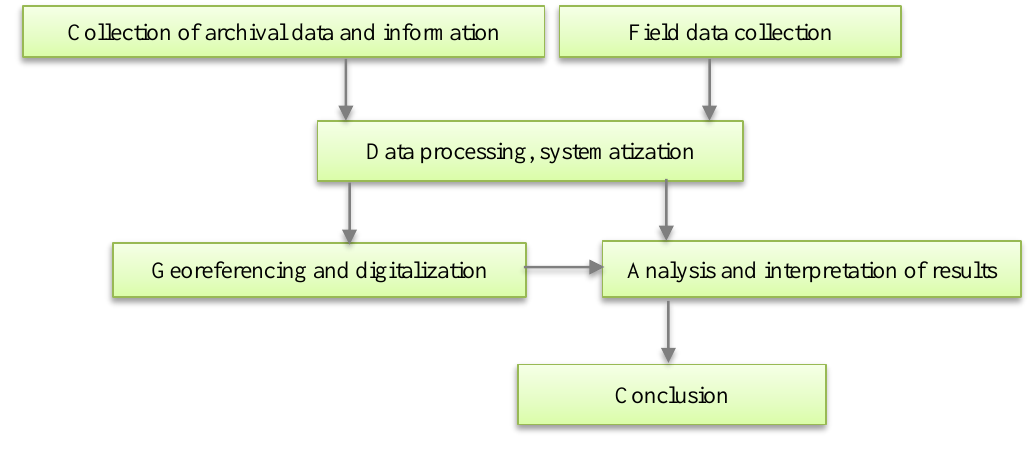
Figure 8. Flowchart of work methodology